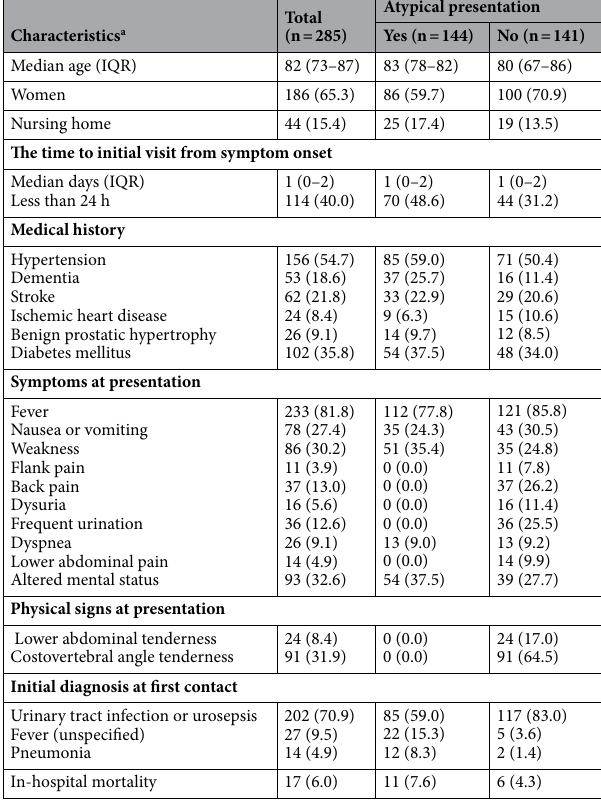
Table 1. Baseline characteristics of 285 patients with bacteremic urinary tract infection. a Values are expressed as numbers with the percentages of the total numbers, unless otherwise stated.